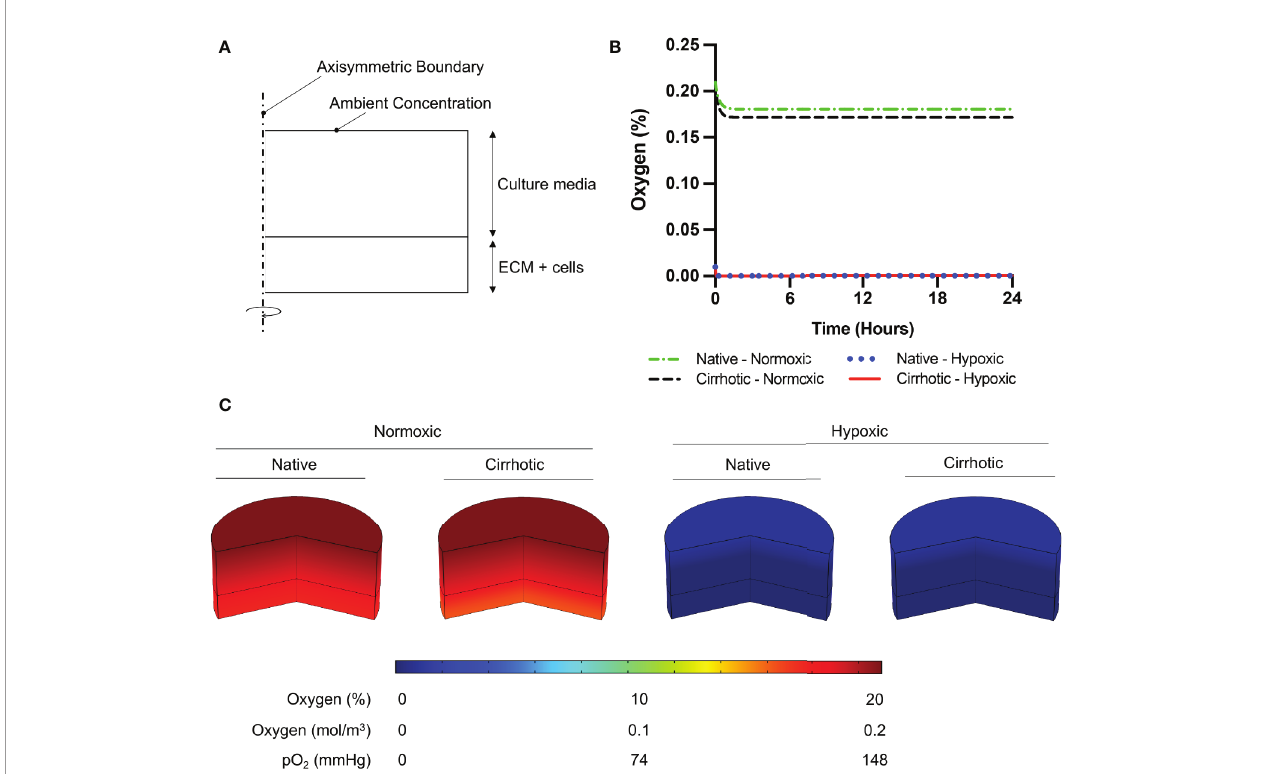
FIGURE 1 | Oxygen depletion modeling in ECM and culture media. (A) Computational domain of the problem in 2D axisymmetric con fi guration. (B) Temporal average oxygen concentration in collagen hydrogels. Oxygen concentration distribution reaches steady state less than one hour after cell seeding. No marginal variation was observed in oxygen concentrations between native and cirrhotic hydrogels. (C) 3D contour of oxygen concentration across the collagen hydrogel and culture media after system reaches steady